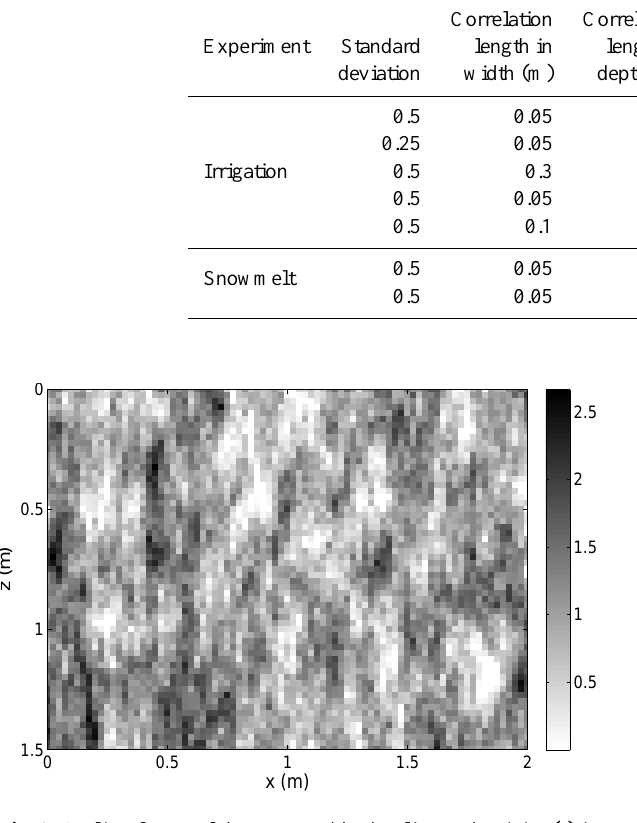
Fig. 9. Scaled solute flux density (d − 1 ) from simulations, at 0.5 m depth, for the year 1997. (a) . Tracer (b) . Degradable solute (half-life time τ =10 d).